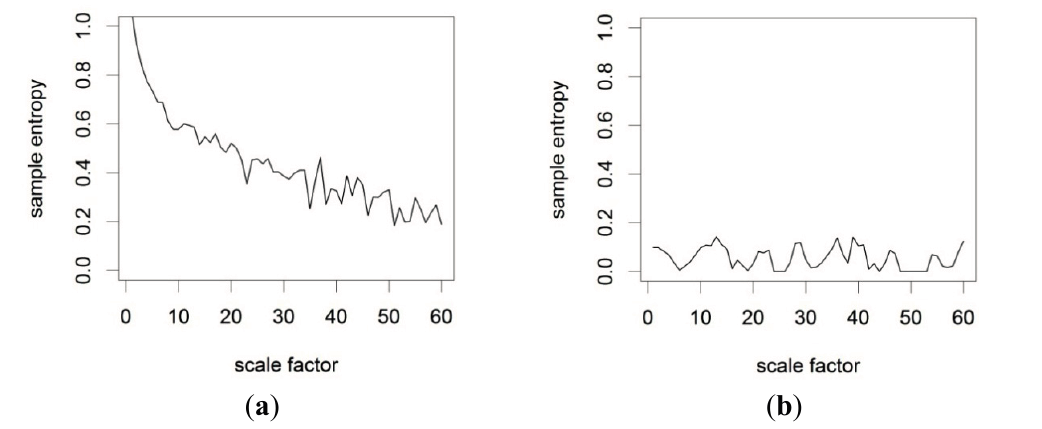
Figure 2. Multi-scale sample entropy of: ( a ) an artificial uniform white noise time-series; and ( b ) a sine